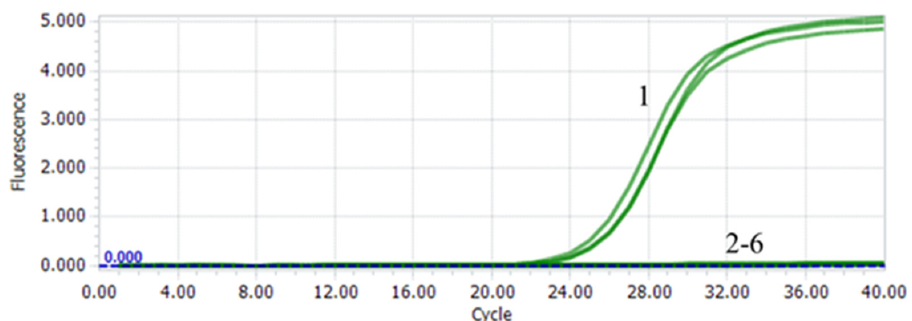
Figure 2. The specificity amplification curve of PTP2-qPCR. The templates for the qPCR were the DNA extracted from shrimp infected with 1. EHP; 2. WSSV; 3. SHIV; 4. VP AHPND ; and 5. healthy shrimp; 6: water.